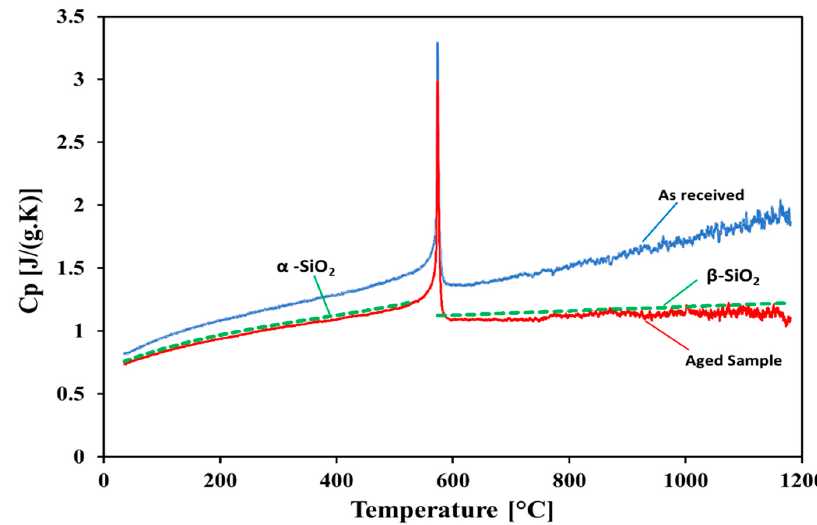
Figure 9. Specific heat measurements of the white sand sample.